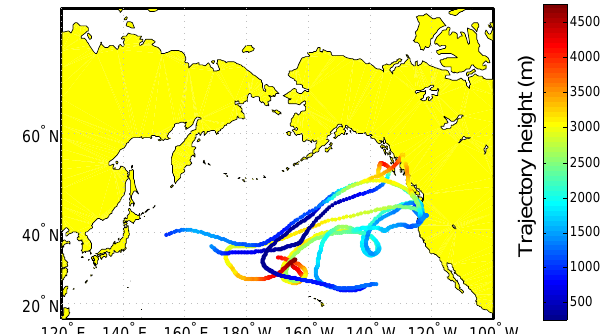
Fig. 5. A negative correlation was observed between RGM and GEM during high-RGM events. Elevated total mercury (THg) and RGM concentrations (peak RGM values of 200–700pgm − 3 , ele- vated by up to ∼ 0.2–0.7ngm − 3 and a factor of ∼ 20–70 above typical background FT levels) were observed during MBL events. The GEM concentrations were higher during ALRT events (THg = 1.65–1.80ngm − 3 ; 1 nanogram per cubic meter ≈ 0.12 parts per trillion by volume at 1.01 bar and 273 K). In general, the MBL events (type 3) show stronger inverse correlations between RGM and GEM compared to ALRT events (type 2).